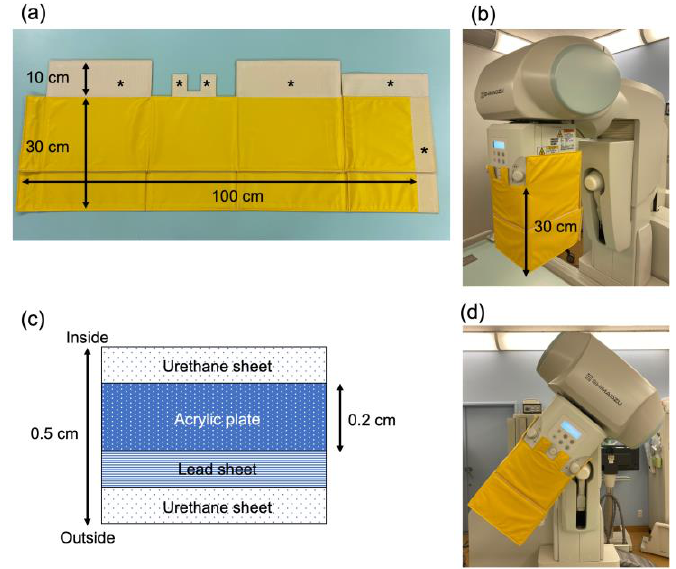
Figure 1. Composition and structure of the short curtain. ( a ) Short curtain composition. Asterisks show portions where hook and loop fasteners are sewn onto the short curtain. ( b ) Short curtain attached to the fluorographic imaging unit. ( c ) Cross-section of short curtain shielding material. ( d ) Short curtain when attached to fluorographic imaging unit and the unit is tilted.